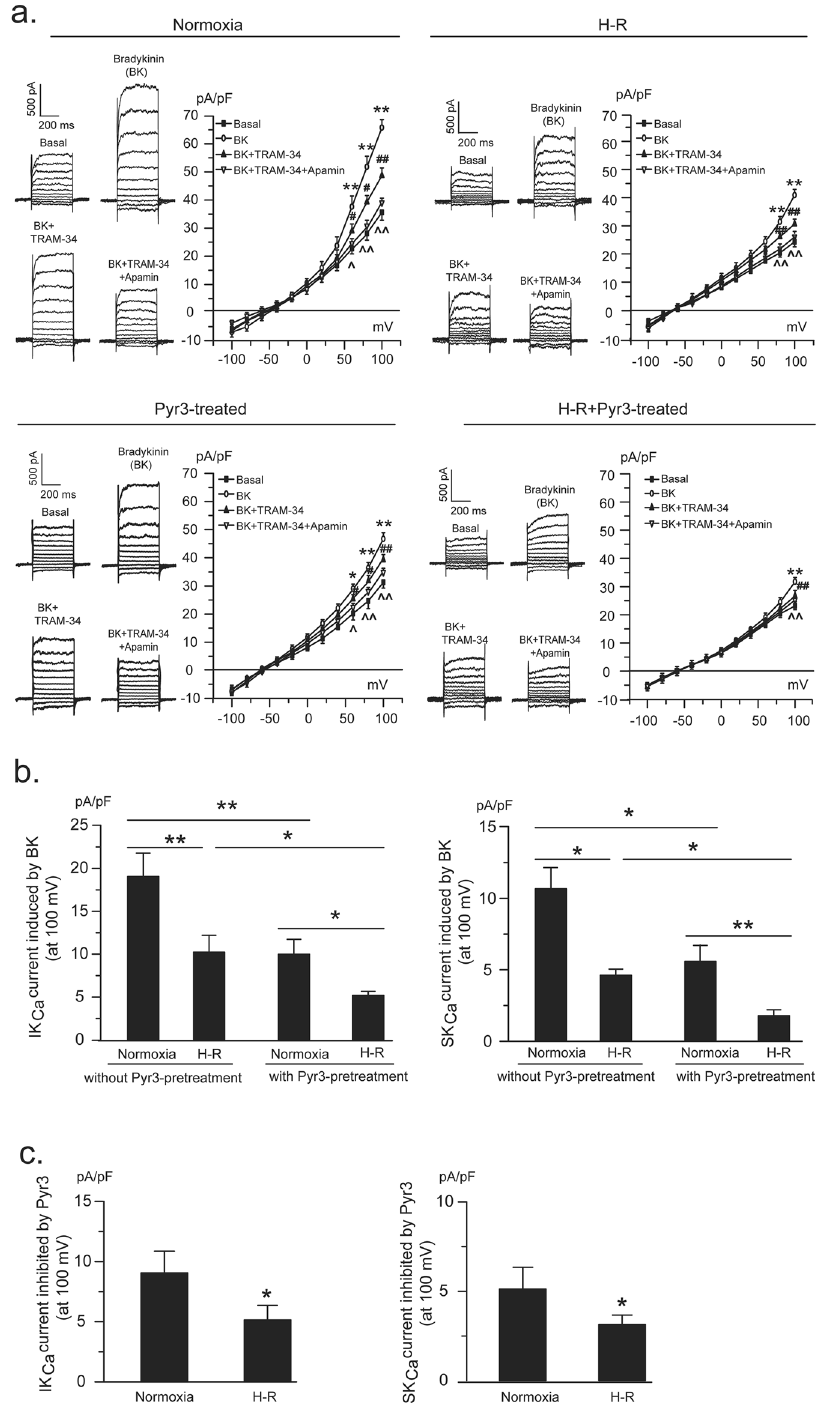
Figure 3. Inhibition of TRPC3 channels contributes to H-R-induced suppression of IK Ca and SK Ca channel activity in PCAECs. Representative traces and current-voltage relationship of whole-cell K + current in PCAECs from different treatment groups before and after bradykinin (BK) stimulation with further application of the IK Ca channel blocker TRAM-34 and the SK Ca blocker apamin ( a ). In H-R group, cells were exposed to 60-min hypoxia and 30-min reoxygenation before patch-clamp recording. * p < 0.05, ** p < 0.01, BK vs. basal; # p < 0.05, ## p < 0.01, BK + TRAM-34 vs. BK; ^ p < 0.05, ^^ p < 0.01, BK + TRAM-34 + Apamin vs. BK + TRAM-34. Pre- treatment of PCAECs with the selective TRPC3 channel blocker Pyr3 significantly inhibited BK-induced IK Ca and SK Ca channel currents under both normoxic and H-R conditions ( b ). Pyr3 exhibited less inhibition on both components of IK Ca and SK Ca induced by BK when compared with the cells without H-R exposure ( c ). * p < 0.05, ** p < 0.01, one-way ANOVA and Scheffe post-hoc test ( a and b ) and unpaired t test ( c ). n = 5 in each group. N indicates the number of independent experiments, each obtained from cell isolates of different